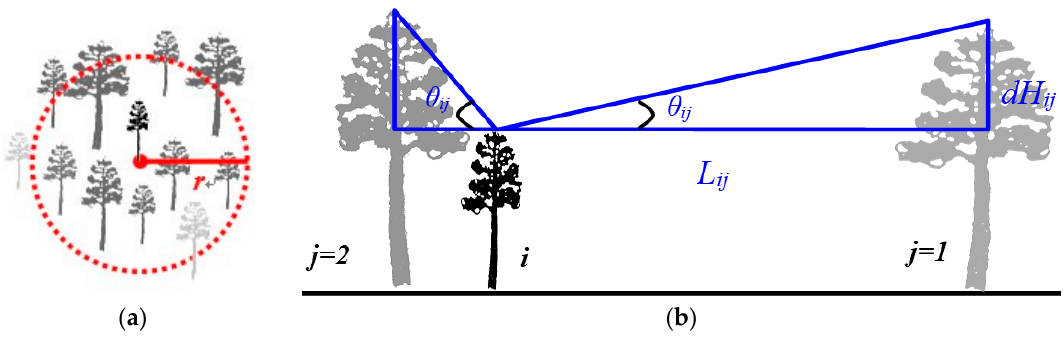
Figure 3. The relationship between a subject tree and its competitors. ( a ) The proximity area is defined based on the location of the subject tree and a radius r ; ( b ) The angle θ ij is the competition pressure exerted on a subject tree i by a neighboring tree j in the proximity area.